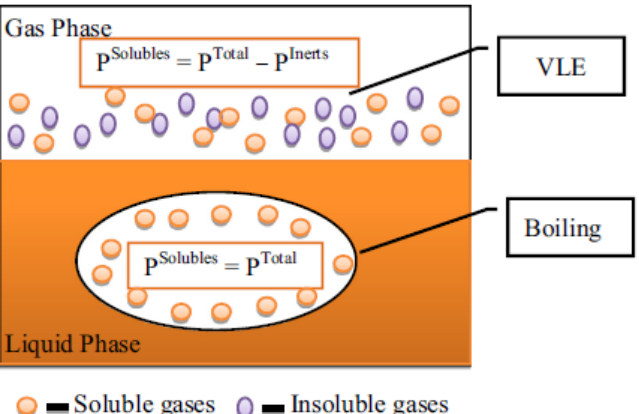
Figure 2. A schematic diagram for the comparison between the pressure in vapour–liquid equilibrium and boiling [41]. P Total is the total pressure of the system, P Inerts are the total partial pressures of all the virtually insoluble gases, and P Solubles is the total partial pressure of the soluble gases.